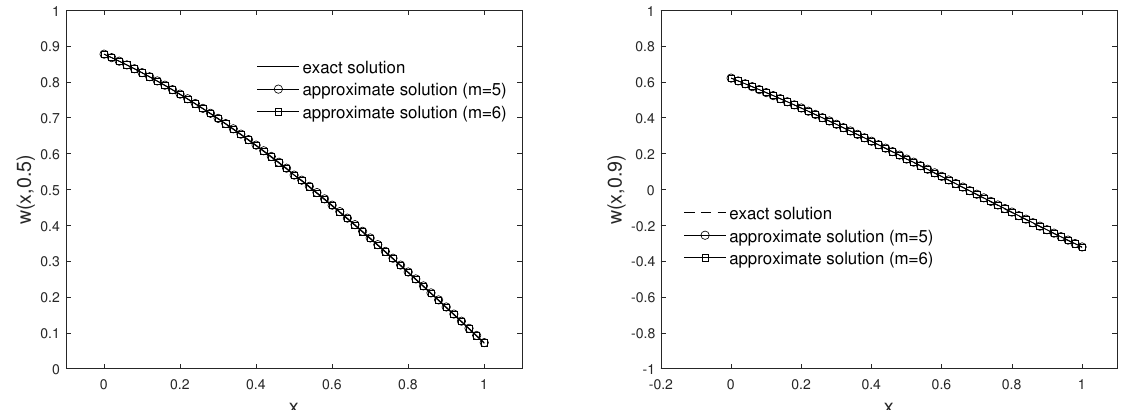
Figure 4. Plot of exact and approximate solutions at time t = 0.5 and t = 0.9 taking θ = 1/2, r = 5, J = 2 and δ t = ( 0.1 ) /2 m for Example